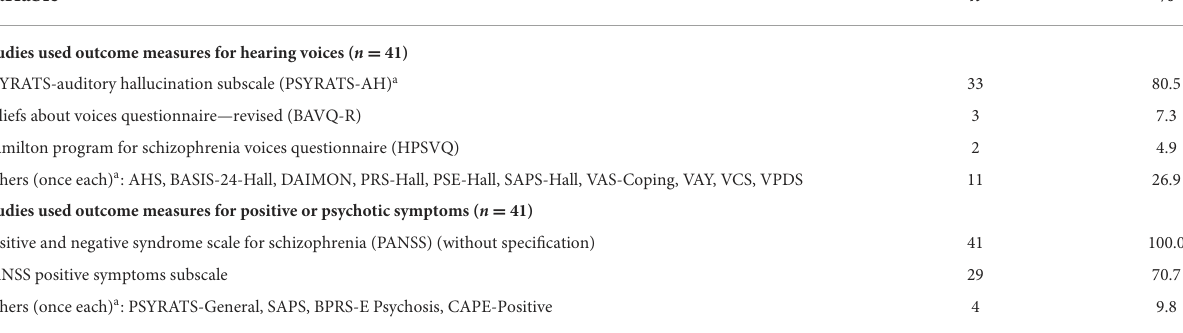
TABLE 2 Outcome measurements used in the quantitative studies ( n = 69). Variable n